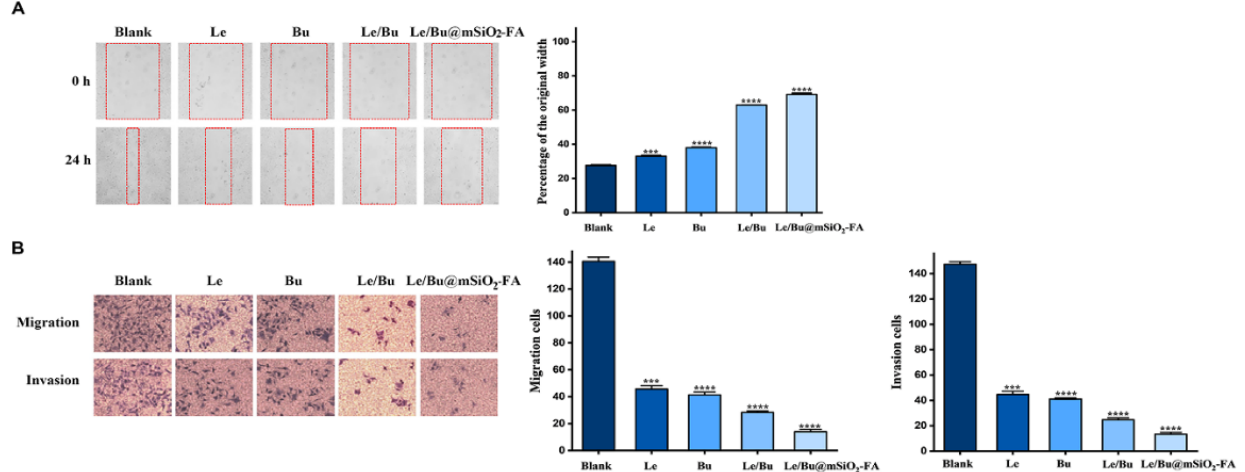
Figure 5. ( A ) Scratch assay of 9810 cells (control, free Le treatment, free Bu treatment, Le/Bu combi- nation treatment, and Le/Bu@mSiO 2 -FA treatment) at 0 and 24 h (N = 3). ( B ) The cell migration and invasion of 9810 cells treated with control, free Le, free Bu, Le/Bu combination, and Le/Bu@mSiO 2 - FA for 24 h was detected by Transwell assay (N = 3). The invading and migrating cell numbers were then quantified by counting and depicted as bar charts. *** p < 0.001, **** p < 0.0001. Le—Lenvatinib; Bu—Bufalin; Le/Bu—Lenvatinib and Bufalin combination.